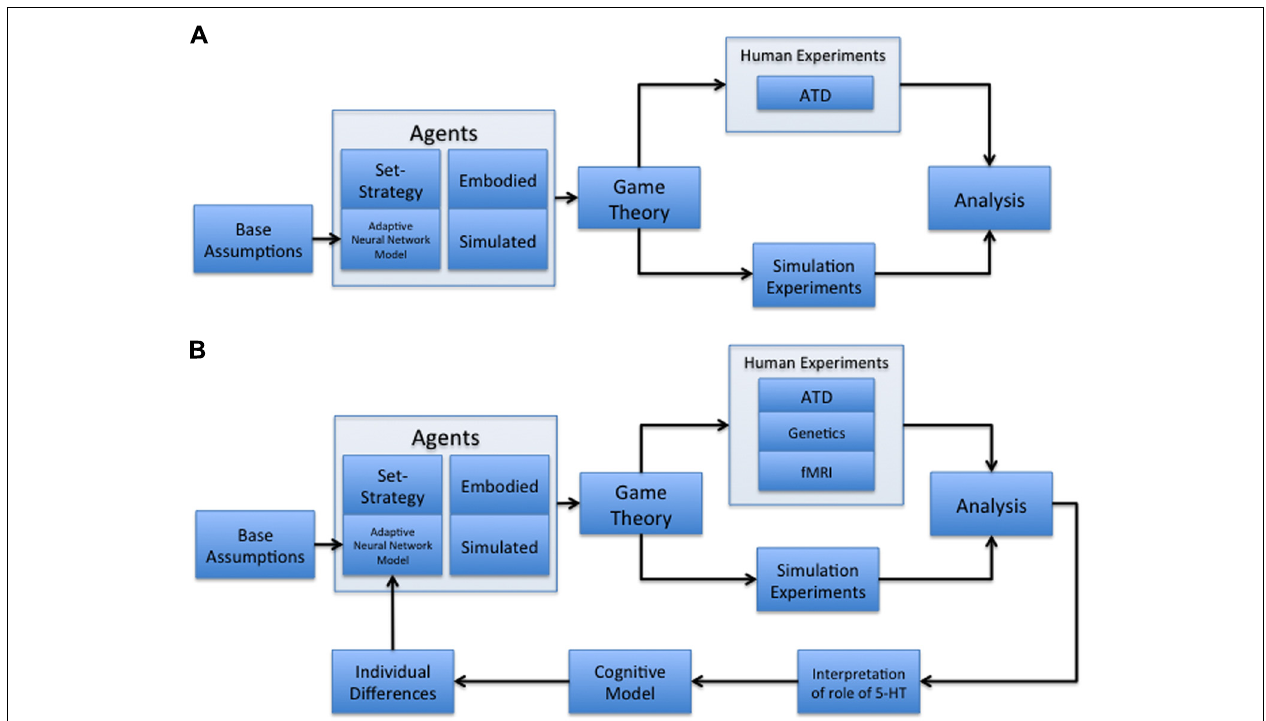
FIGURE 1 | Multidisciplinary paradigms. (A) Multidisciplinary paradigm for investigating the role of serotonin in decision-making and behavior. The model begins with base assumptions regarding neuromodulation, which are then used to develop an adaptive neural network model of cost and reward assessment. This network is embedded in an agent acting as a player in a game theoretic environment, alongside control conditions with set-strategy agents. These agents are both embodied in robotic players and simulated in computer-based games. The agents are used in both human and simulation experiments to assess the adaptive network’s ability to behave naturally, as well as the human subjects’ reactions to the adaptive agent compared to set-strategy agents. Human subject experiments under this paradigm can include acute tryptophan depletion (ATD) manipulations. The results from human and simulation experiments are then processed to determine the validity of any hypotheses developed at the outset, in addition to the appearance of interesting emergent